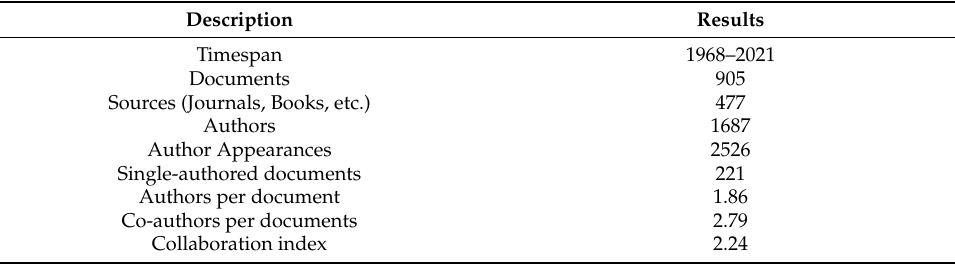
Table 1. Main information about bibliographic data collection.